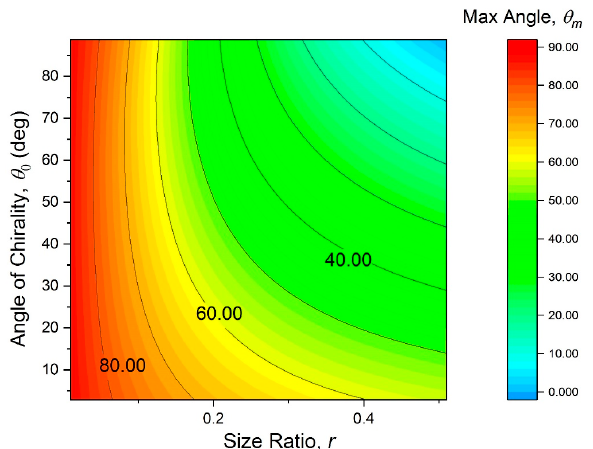
Figure 10. Contour map of the maximal allowed nodal rotation angle, θ m . The corresponding maximal operational temperature of the metamaterial is ∆ T m = 2 θ m ( rad ) / aL